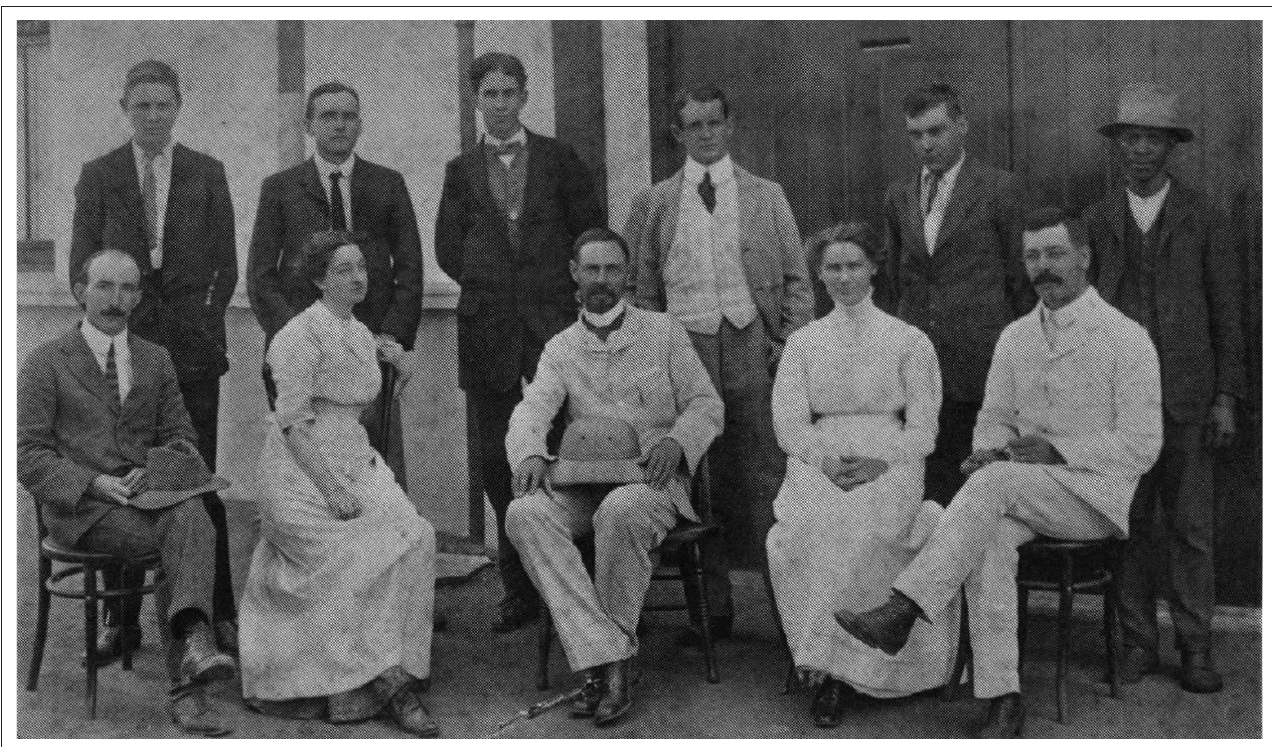
FIGURE 3: Dr Joseph Burtt Davy (1870–1940), seated in the centre, and Miss Sydney Margaret Stent (1875–1942), seated to his right.